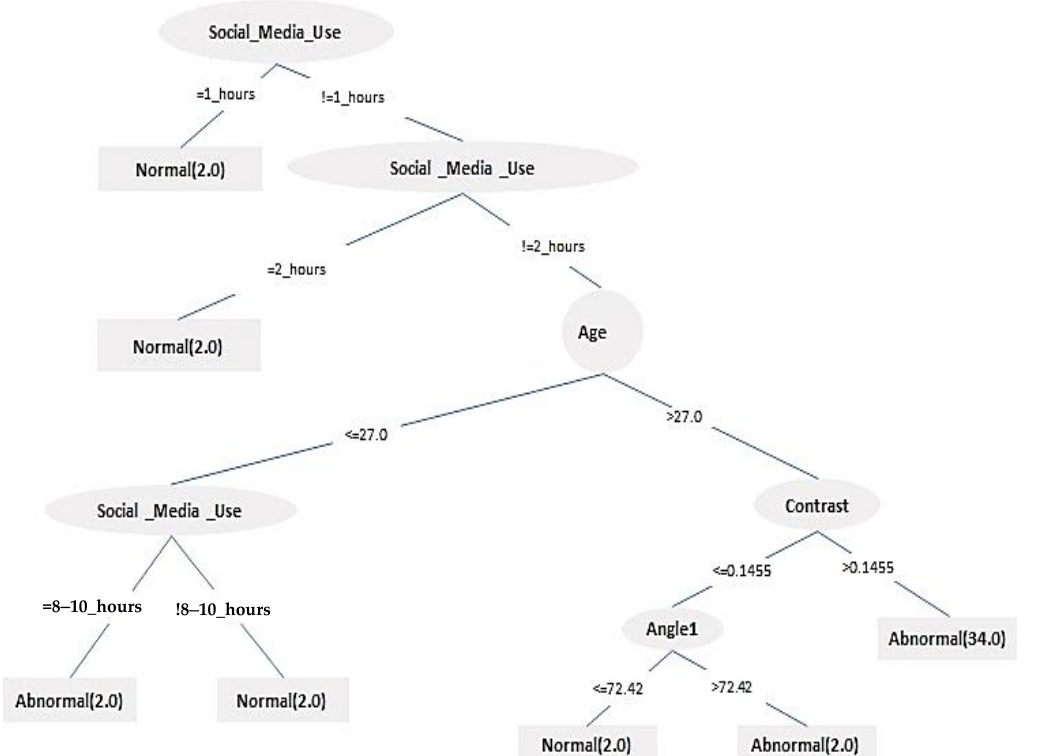
Figure 9 . Generated decision tree to predict the effect of SM usage on neck pain. Figure 9. Generated decision tree to predict the effect of SM usage on neck pain.